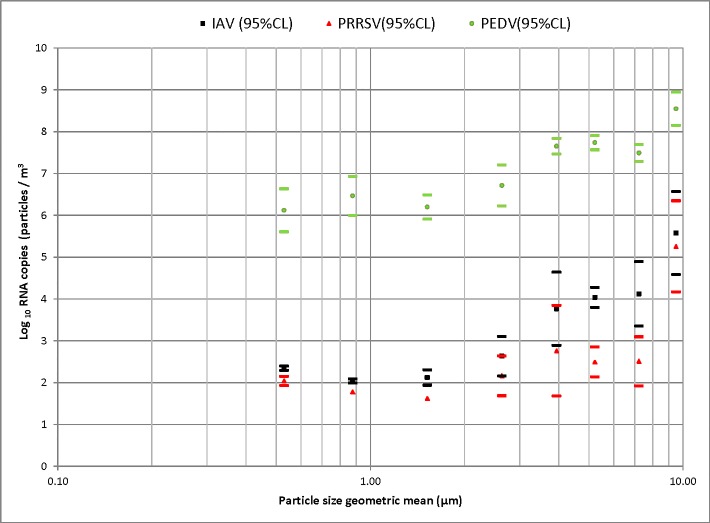
Particle size distribution of airborne viruses.Particle size distribution (Least Squares Means of log10 RNA copies/m3 of air and 95% confident interval) for influenza, porcine reproductive and respiratory syndrome and porcine epidemic diarrhea viruses detected by the Andersen cascade impactor from aerosols generated by infected pigs.